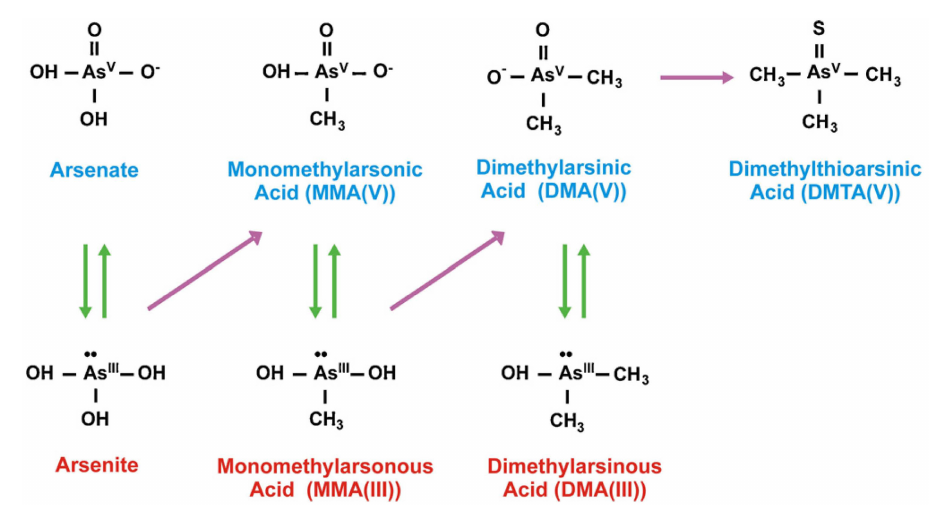
Figure 5. Metabolic pathway of inorganic arsenic. Reprinted from Chilakpati [168] with permission from